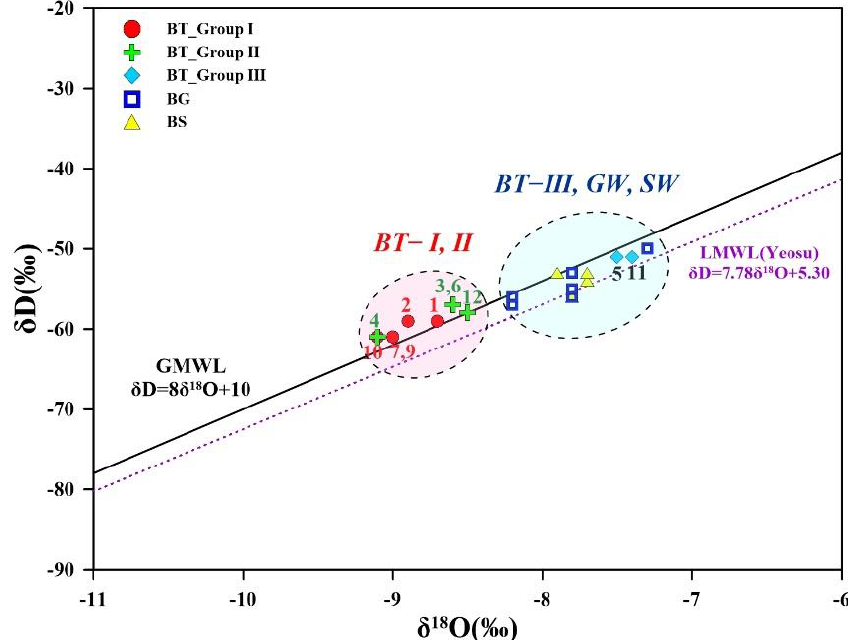
Figure 5. Relationship between δ 18 O and δ D in the thermal water, groundwater, and stream water in the study area. GMWL: Global Meteoric Water Line; LMWL: Local Meteoric Water Line according to the precipitation data from the Yeosu area, about 114 km distant).